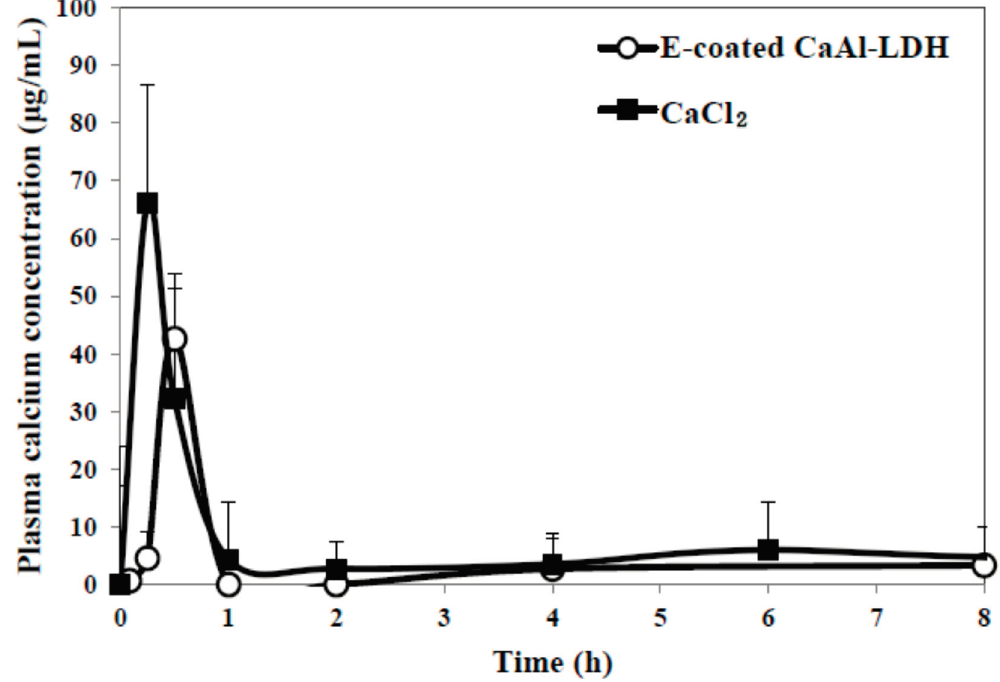
Figure 7. Plasma concentration-time curve of E-coated CaAl-LDH after a single dose oral administration to rats. Equivalent amount of CaCl 2 based on calcium content was also treated as a control